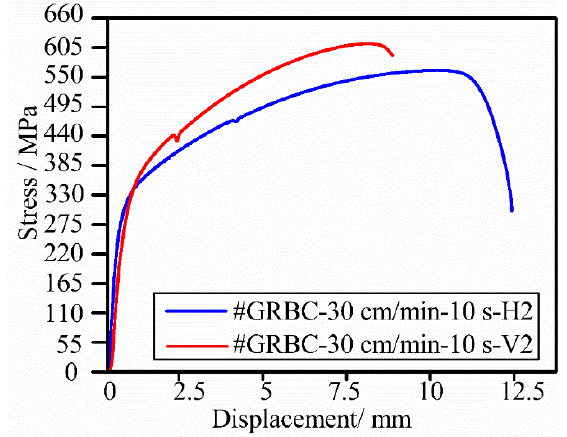
Figure 11. Stress-displacement curves of sample #GRBC-30 cm/min-10 s (#GRBC-30 cm/min-10 s-H2 and #GRBC-30 cm/min-10 s-V1 represent the horizontal and vertical tensile specimens of sample #GRBC-30 cm/min-10 s, respectively). (TRBC and GRBC represent transient and gradual reduction of bottom current, respectively).